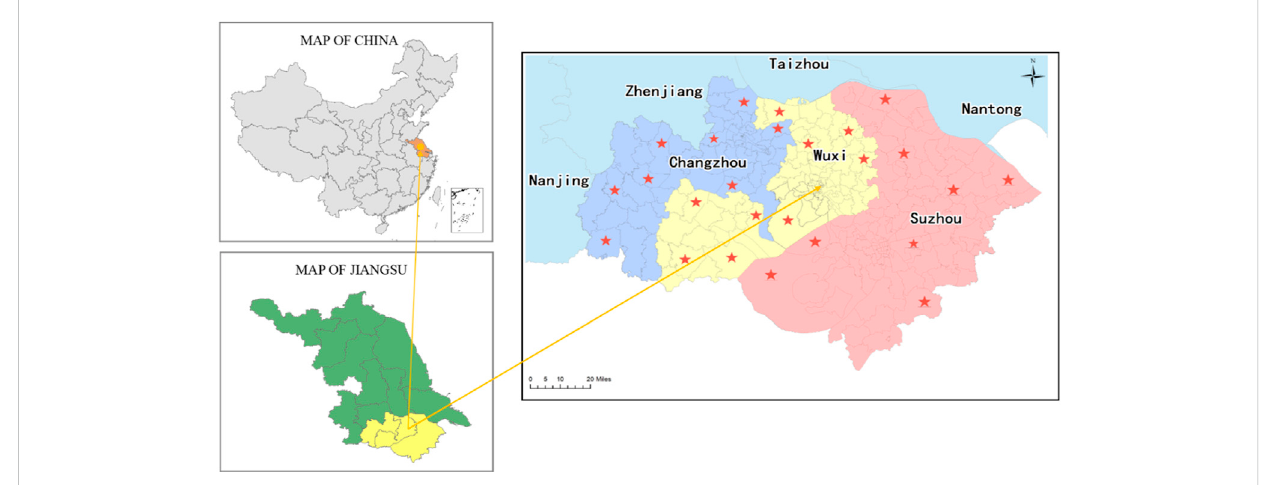
FIGURE 2 Sample villages distribution.